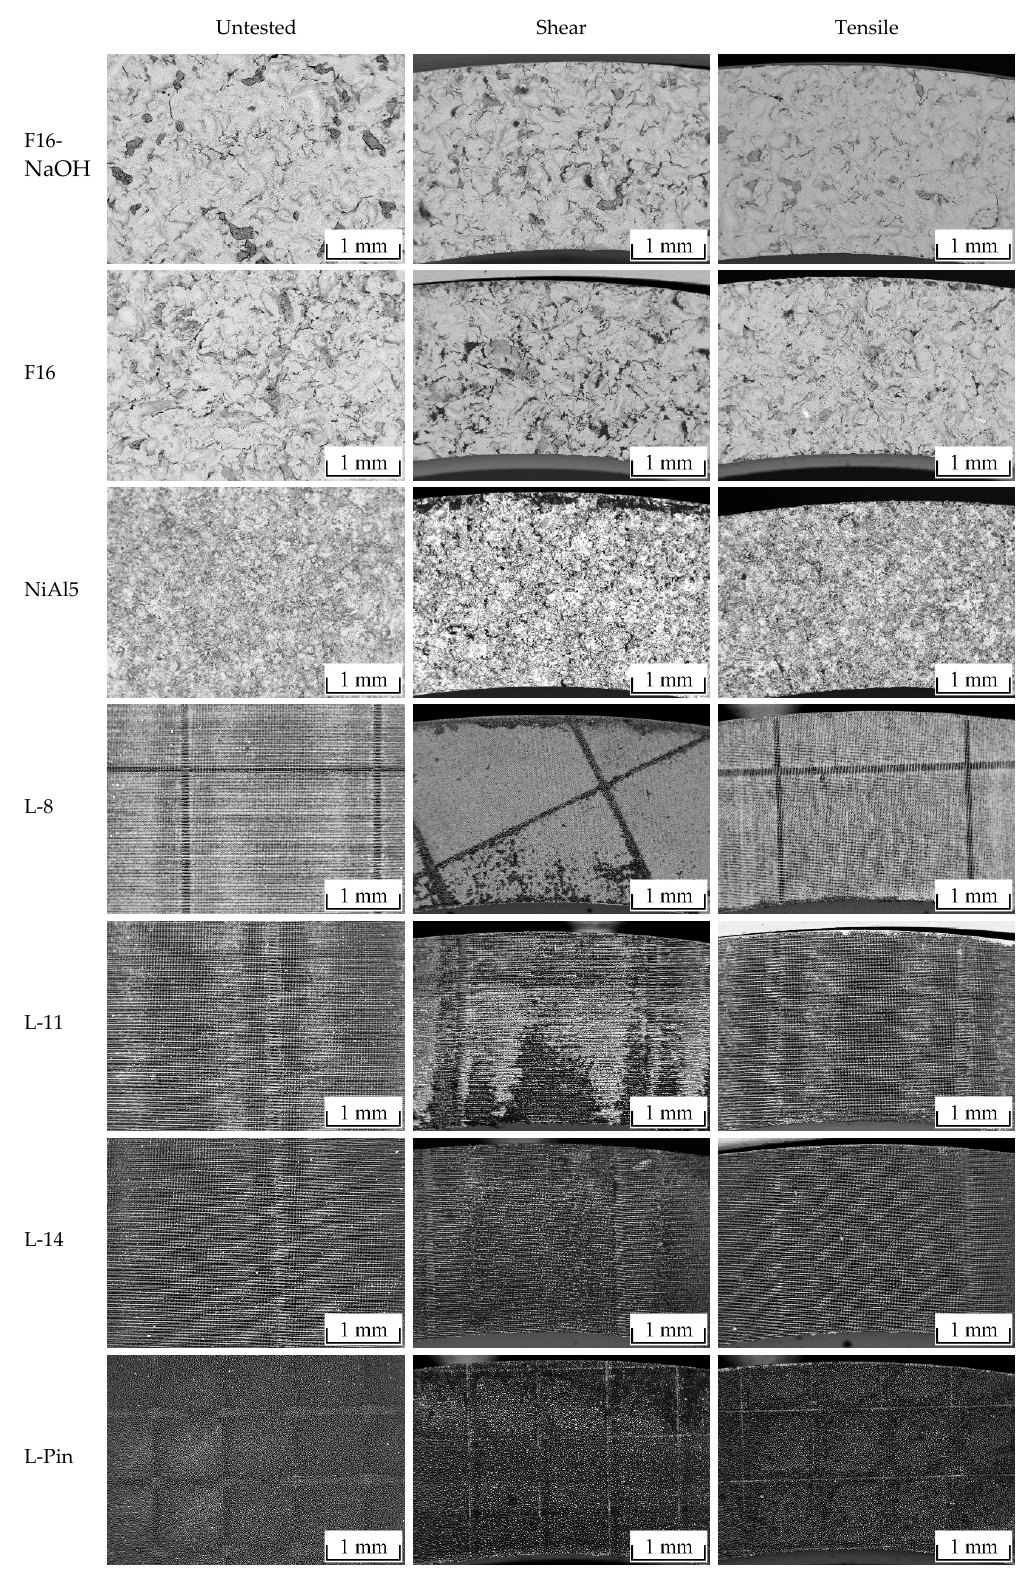
Figure 11. BSD images of the fractured metal surfaces.